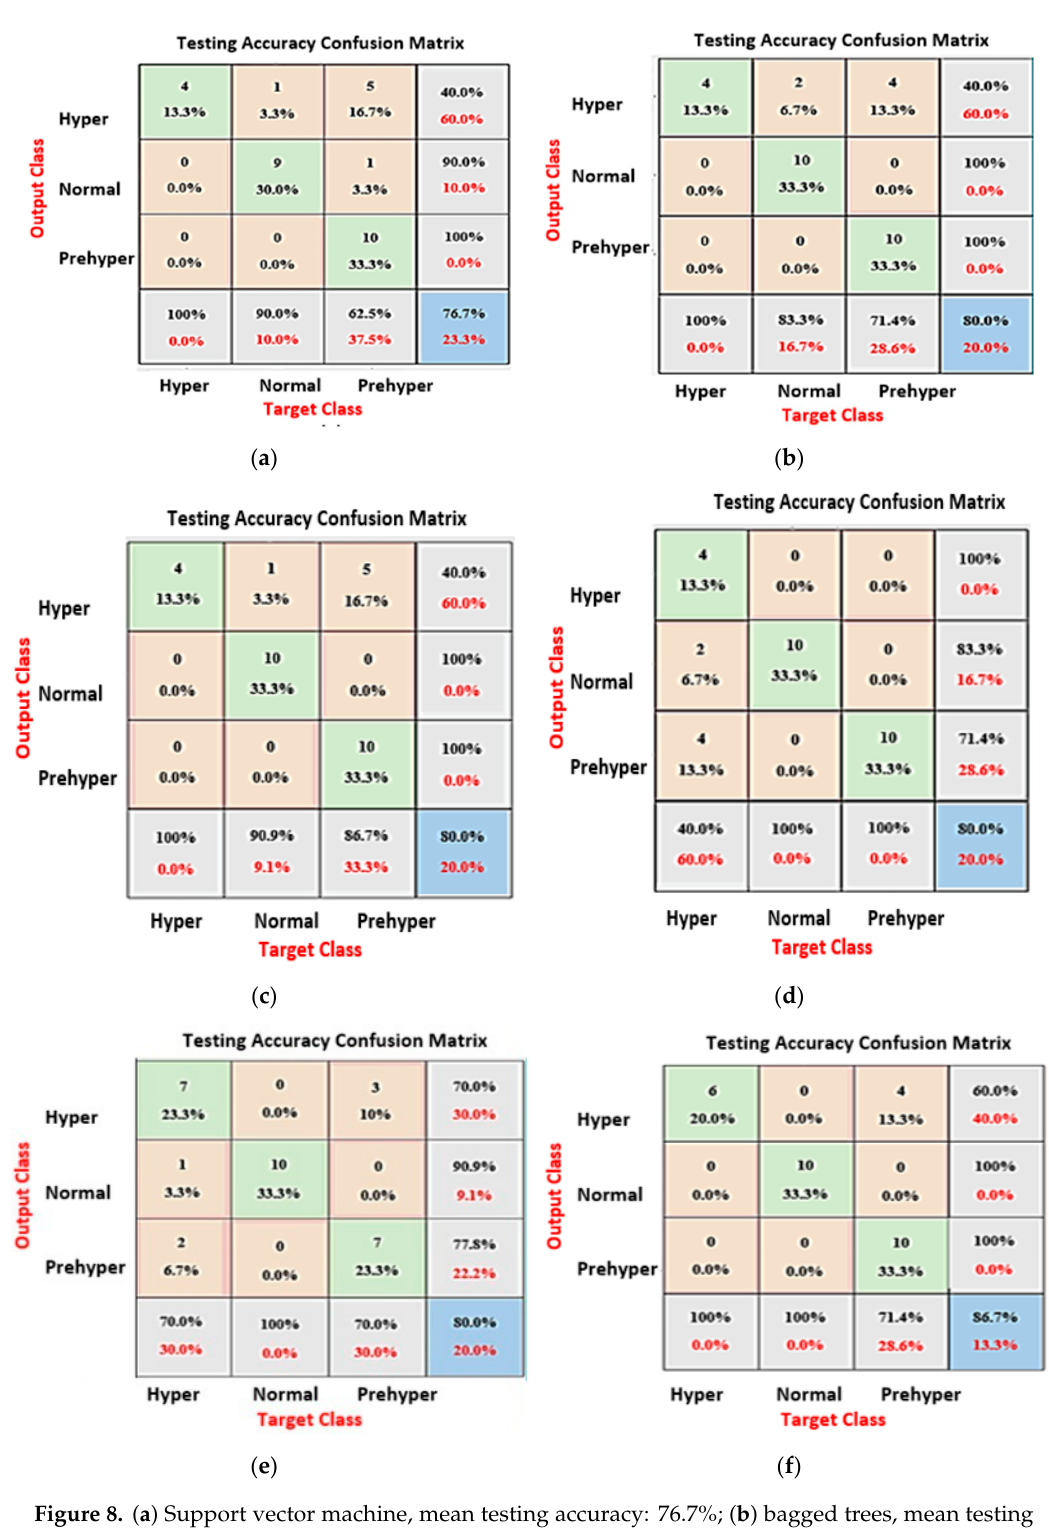
Figure 8. ( a ) Support vector machine, mean testing accuracy: 76.7%; ( b ) bagged trees, mean testing accuracy: 80%; ( c ) discriminant analysis, mean testing accuracy: 80%; ( d ) decision tree, mean testing accuracy: 80%; ( e ) long short-term memory, mean testing accuracy: 80%; ( f ) K-nearest neighbor, mean testing accuracy: 87.6%.